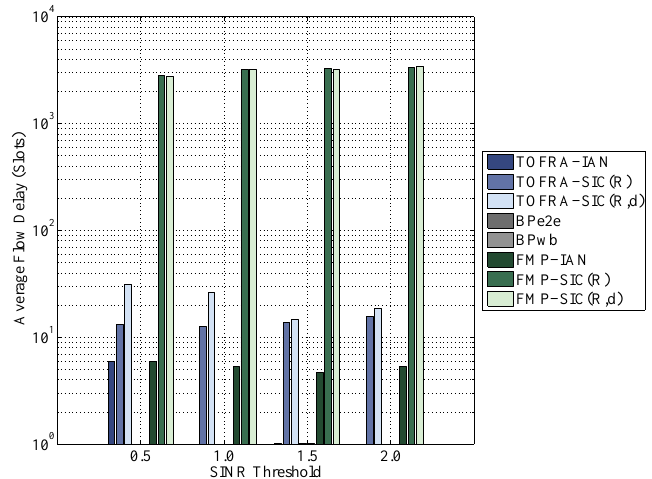
Figure 8. Topology 3: flow delay per flow allocation